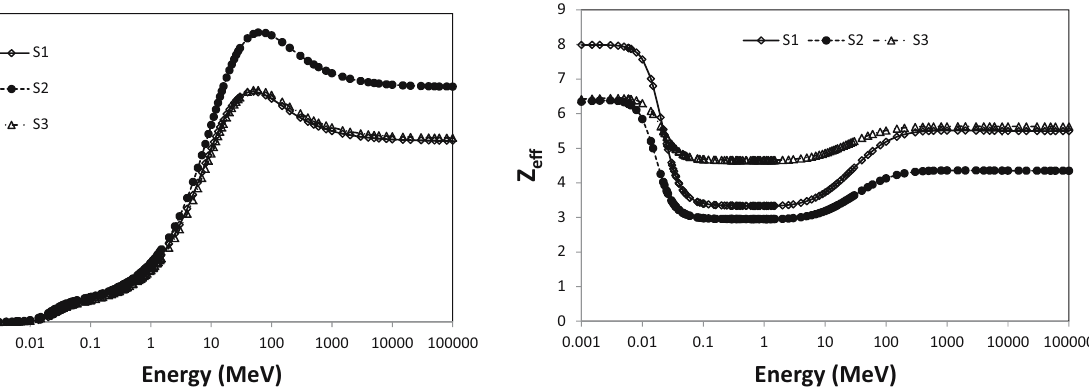
Figure 5: The mfp distribution with the gamma - ray energies.